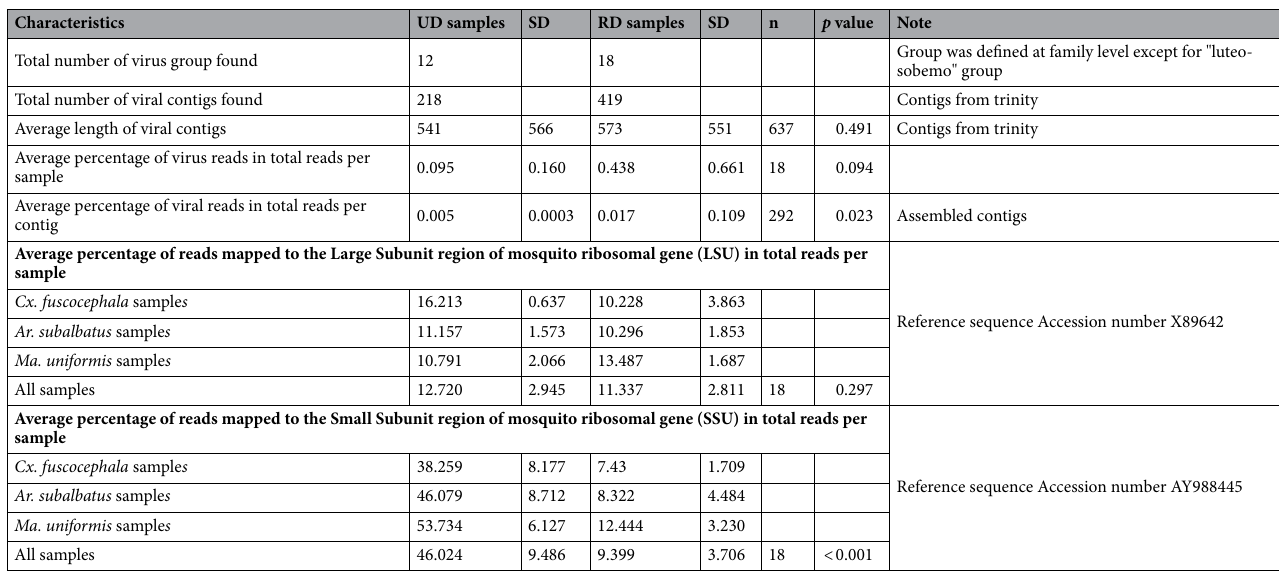
Figure 3. Similarity of virus community ( a ) and bacteria community ( b ) from RD samples. A Principle Component Analysis was performed based on log-transformed read numbers of bacterial and virus taxa found in each mosquito species and habitat type.